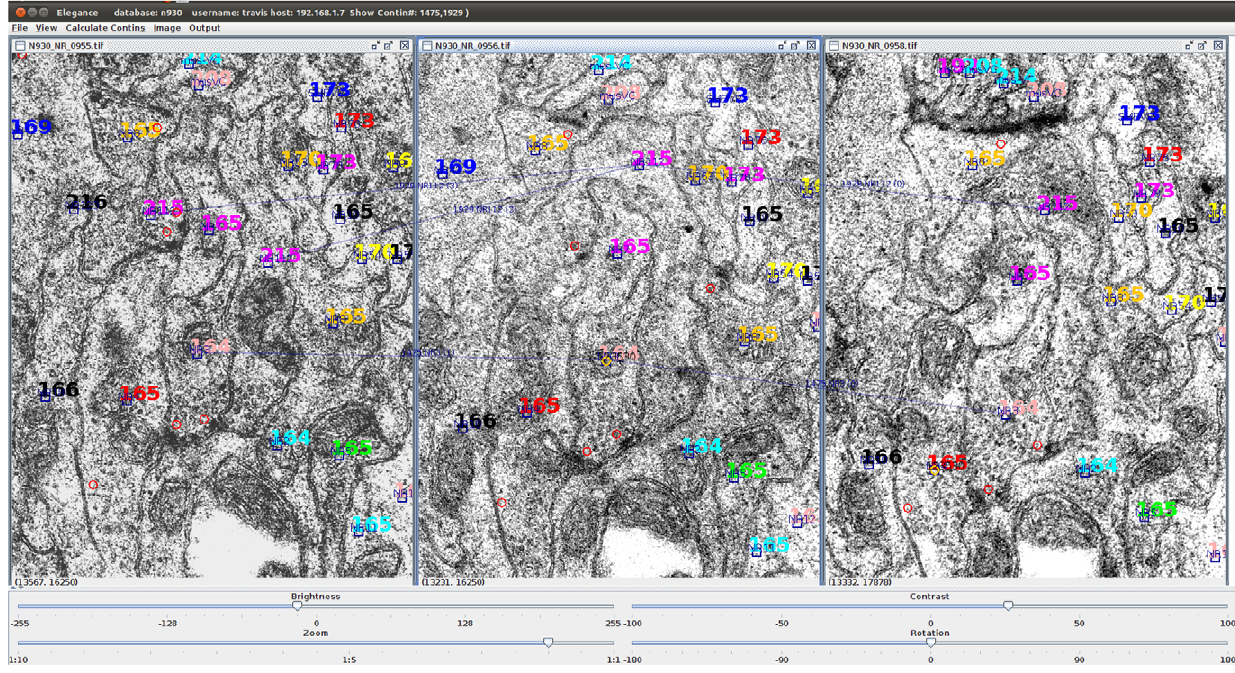
Figure 1. Elegance screenshot. Cell profiles are marked by open blue squares. Different chains of connected objects are labeled with a colored number for ease of recognition. The pink 215 neuron branches between the central and left-hand images. Synapses are marked by red circles. Table. Additional information includes user identity, date of entry, degree of certainty, membership in a contin, and so forth.